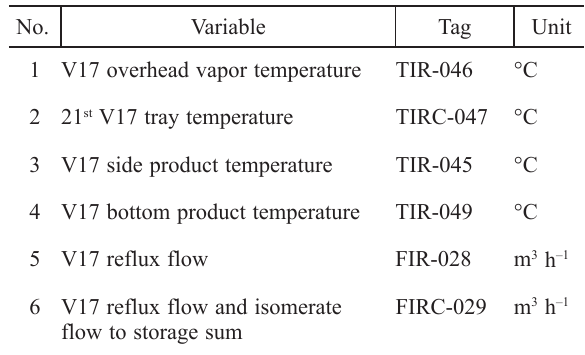
Table 7 – Input variables for the development of 2-MP con- tent SVM model